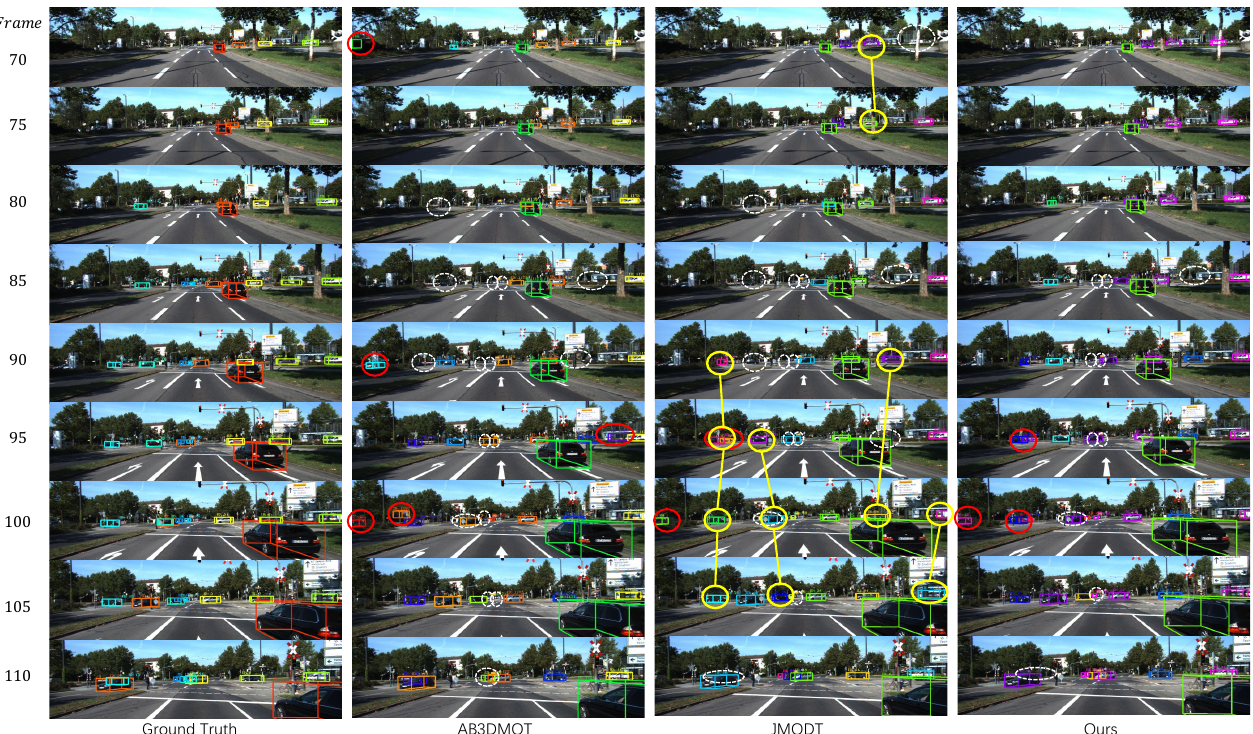
Figure 7. Visualization of tracking comparisons between the ground truth, baseline, and our improved work on trajectory 2D images of the KITTI [9] dataset. The squares indicate the detected objects. The red circle indicates false detection, the white dotted circle indicates missing detection, and the yellow circle indicates IDSW. All datasets and benchmarks on KITTI [9] are copyright by KITTI and published under the Creative Commons Attribution-NonCommercial-ShareAlike 3.0